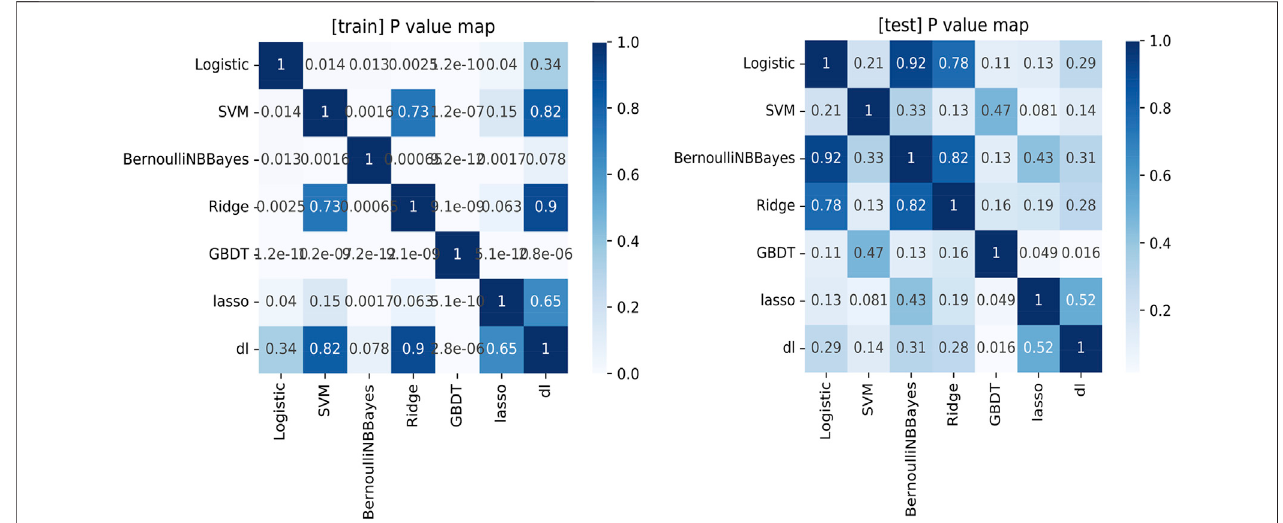
FIGURE 2 | The comparison of the ROC analysis among the machine learning models in the training set and test set.